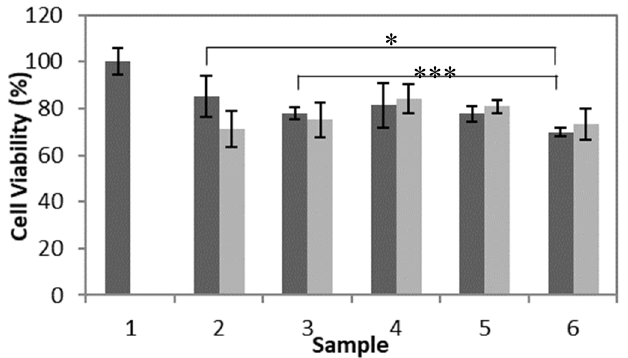
Figure 11. Cell viability of HCEC after incubation with poly(HEMA, BAC, 3AAPBA) nanoparticles Figure 2. days at 37 °C and 5% CO 2 . Samples shown are the control with no nanoparticles (1) and poly(HEMA, BAC, 3AAPBA) nanoparticle formulation C2 (2), C3 (3), C4 (4), C5 (5), and C6 (6) from Table 2. The bars correspond to original concentration ( ■ ) for all samples and 2× dilution ( ■ ). Error bars were obtained from the standard error of triplicate samples. p value < 0.05 (*) and <0.005 (***).